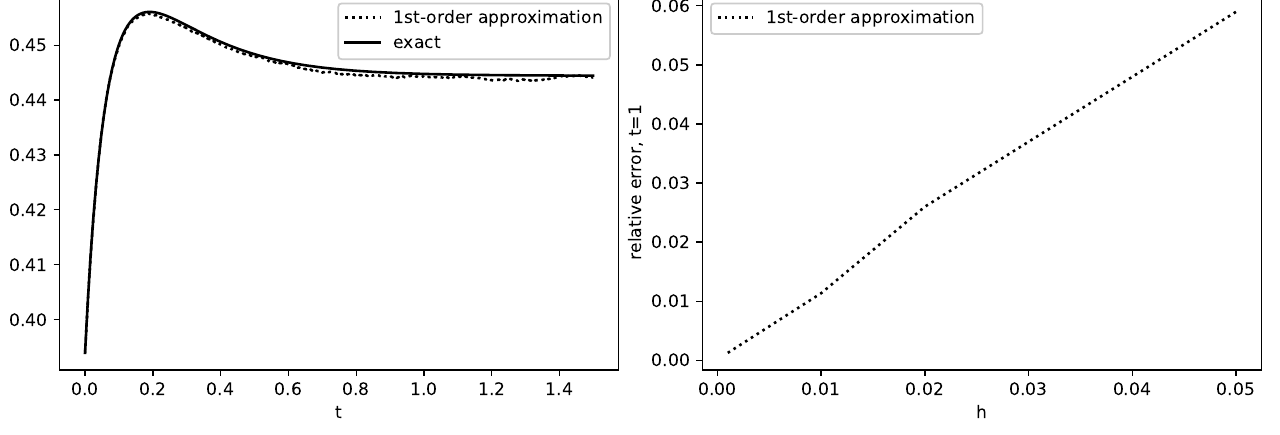
Figure 2. Comparison of E f ( ˆ X x σ 2 = 2, a = 4, b = 5, N = 1,000,000. Left : h = 0.001; Right : the relative error at t = 1.